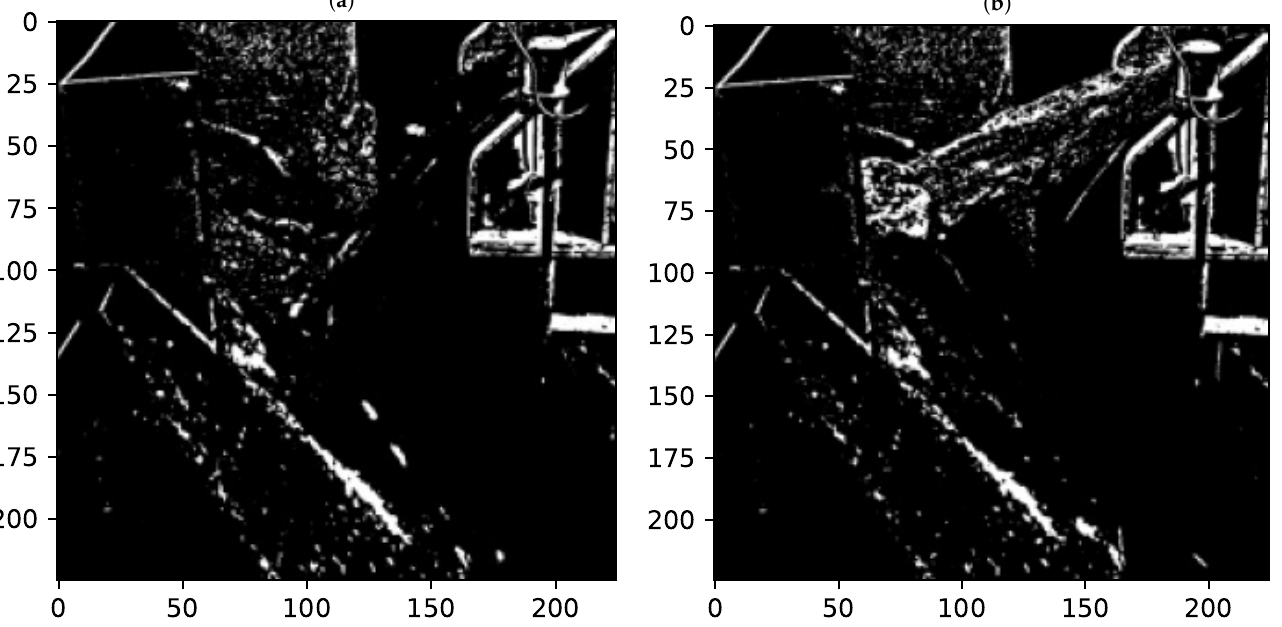
Figure 7. Thresholding results: ( a ) normal condition; ( b ) blockage